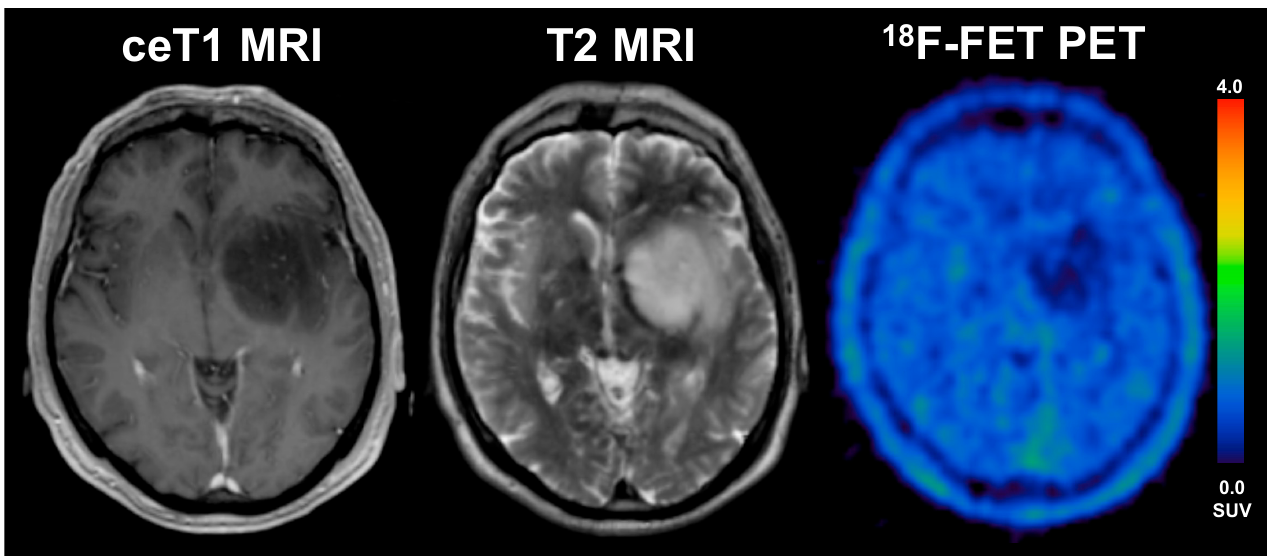
Figure 5. 56-year old male patient with anaplastic astrocytoma (WHO grade III, IDH wildtype, MGMT unmethylated, TERTp wildtype) and a photopenic aspect on 18 F-FET PET. Overall survival was 10 months only (STS) under single therapy with radiotherapy.